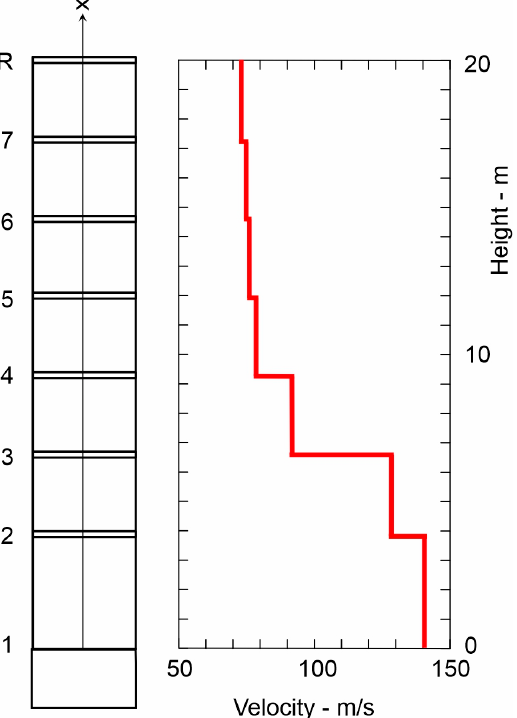
Figure 3. A layered model of the building and the velocity of shear waves in the layers determined by ambient vibration tests [27]. by ambient vibration tests